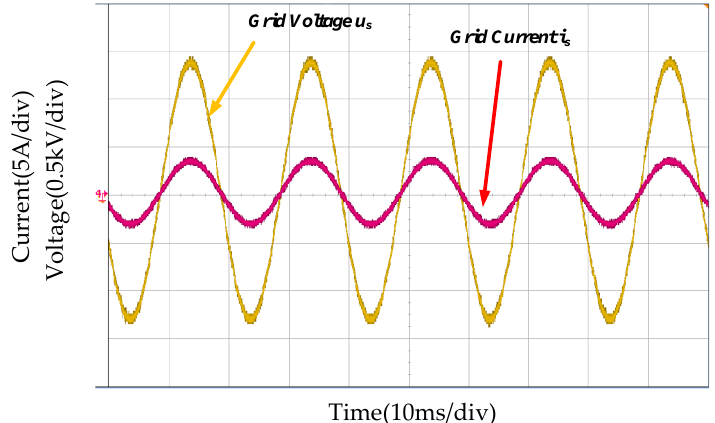
Figure 19. Waveforms of unit power factor operation with flexible OLVR.